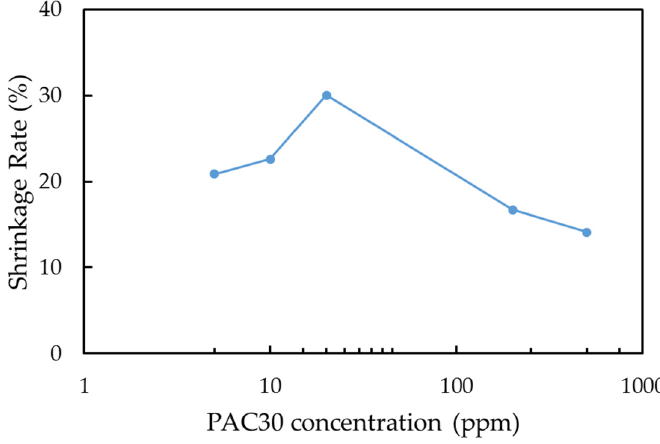
Figure 5. Curve of PAC30 concentration and dynamic shrinkage rate.